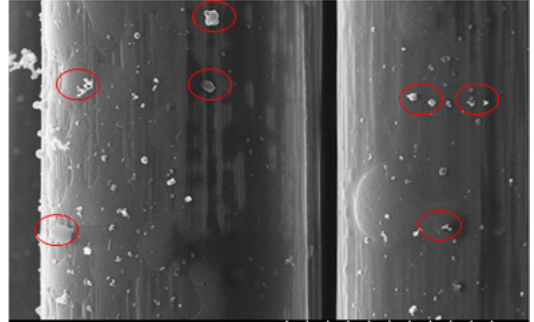
Figure 3. Image of sizing removed state by high pressure.